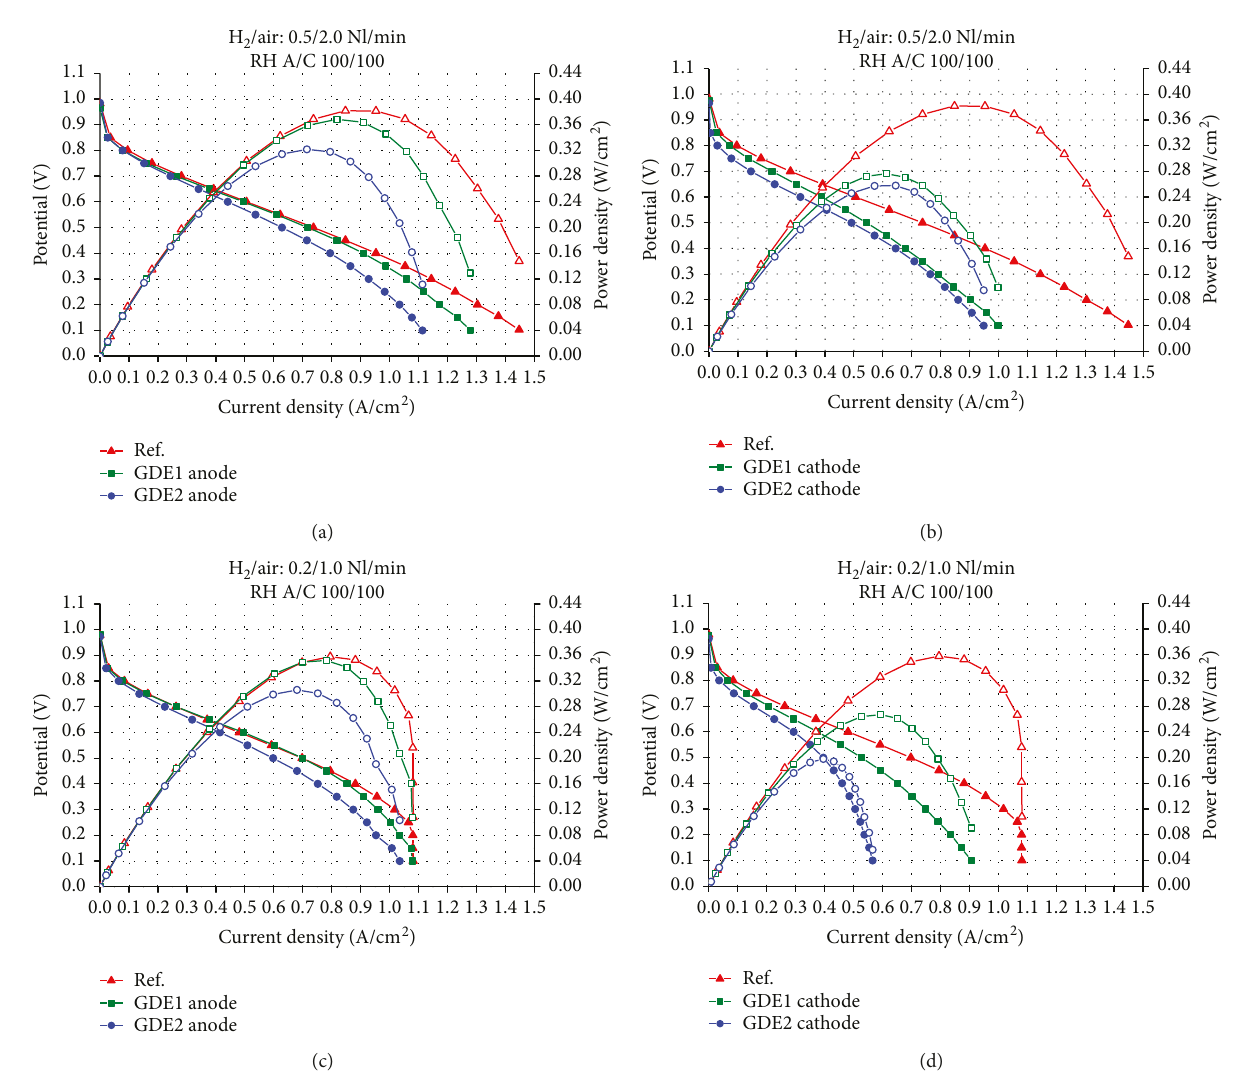
Figure 4: Polarization and power density curves at a high inlet gas fl ow rate (a, b) — 0.5/2Nl/min H (c, d) — 0.2/1Nl/min H 2